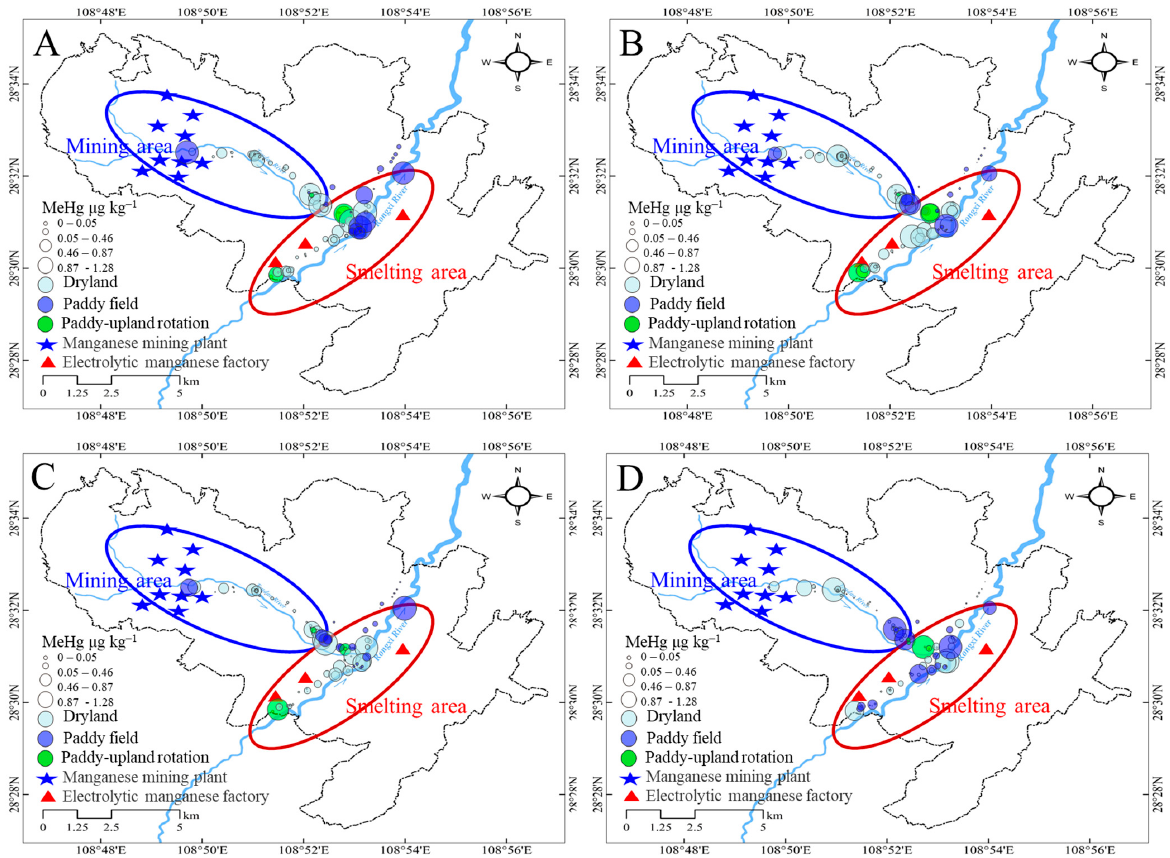
Figure 4. Spatial distribution of MeHg in different soil profiles in the farmlands at mining and smelting areas ( A ): 0–10 cm, ( B ): 10–20 cm, ( C ): 20–30 cm, and ( D ): 30–40 cm).